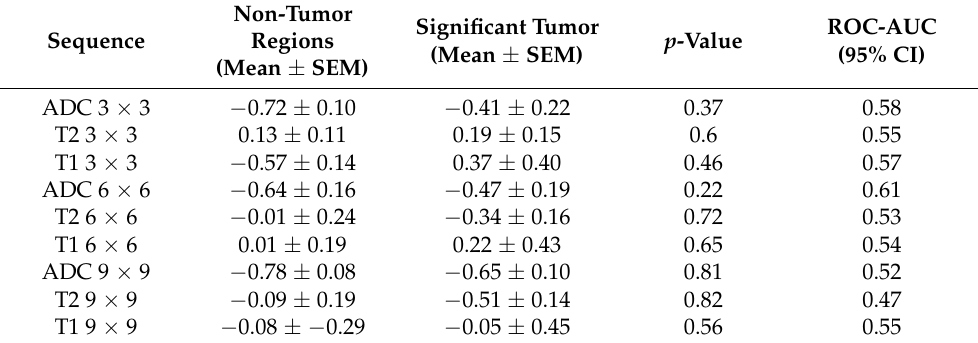
Table 4. Illustrating mean ± SEM value of the ADC map and T 2 - and T 1 -weighted images acquired from a first-order statistical analysis of kurtosis for ROIs containing non-tumors and significant tumors. p -values of differences between ROIs were computed using two-tailed Mann–Whitney U testing. The comparison between ROIs, including tumors and non-tumors, was assessed according to the area under the receiver operator characteristic curve (ROC-AUC) for mp-MRI TA parameters.